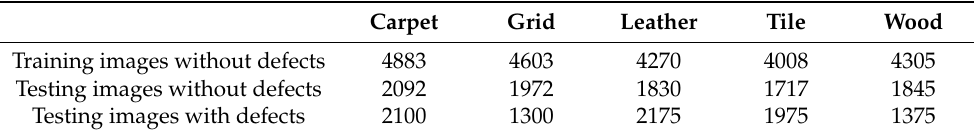
Table 7. Number of images in the modified and resized dataset for training and testing stages. Carpet Grid Leather Tile